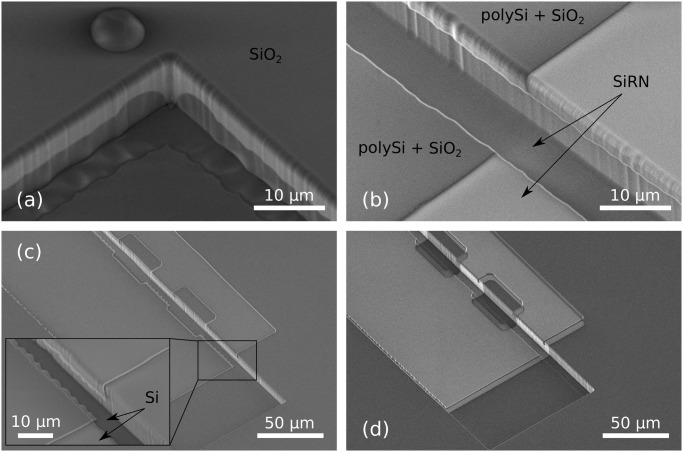
SEM images of fabrication steps for 90° complex hinges.(a): Retraction of polySi is visible under SiO2, Fig 4(g). The polySi plate is not exactly straight. These irregularities are exact replicas of the defects of the silicon mold, which have been magnified through corner lithography. (b): Thick SiRN with patterned masking partially oxidized polySi layer on top. (c): Same as (b) right after wet etching of SiRN. Stress in SiO2 mask causes the curtain-like overhanging thin film. (d): Final structure before release after the second wet etching procedure was applied.